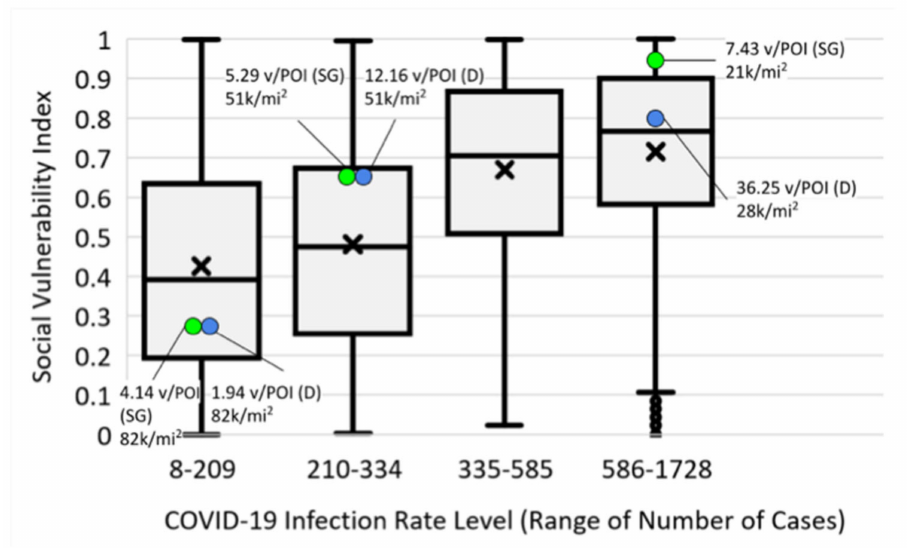
Figure 8. SVI versus COVID-19 infection rate levels on 8 April 2020 (x = mean of each distribution for all locations in Figure 1b; D, DETER data and SG, SafeGraph data for 2–8 April 2020 for the 3 McDonald’s detailed in Figure 4). Green dots show visit levels from SG data, and blue dots represent first-hand observations in the studied communities (as shown in Figure